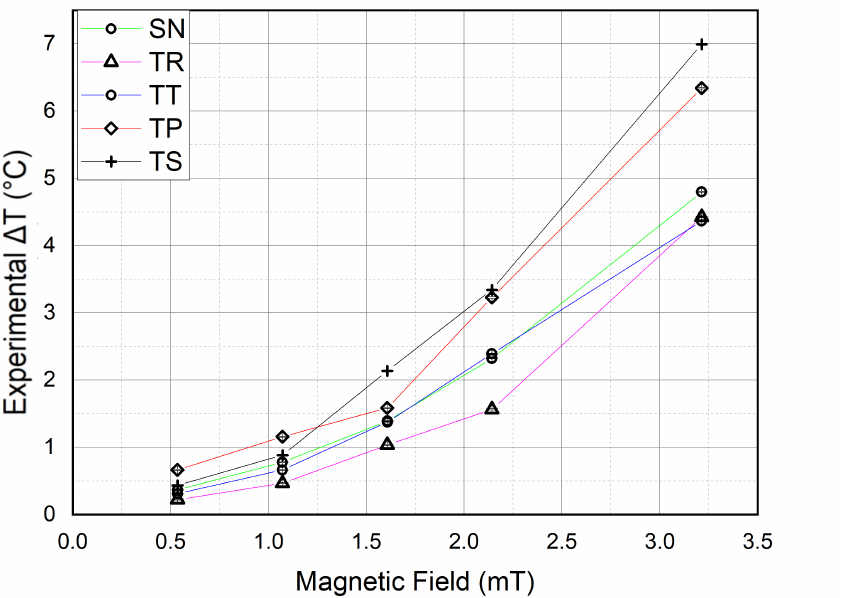
Figure 8. Magnetic intensity effect experiments results of 75 mgFe/mL MNPs at 100 kHz for 900 s at B going from 0.5 to 3.2 mT. The Error bars are barely seen due to their small value (<10 − 3